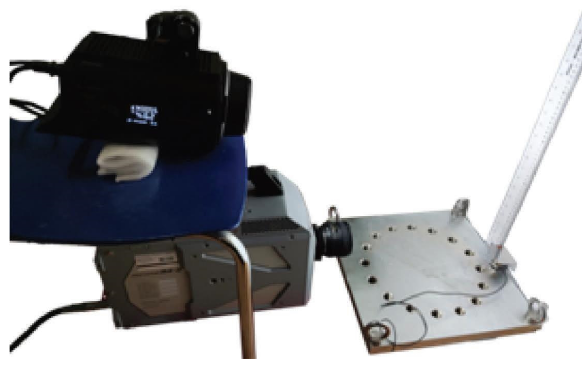
Figure 19: Testing site.